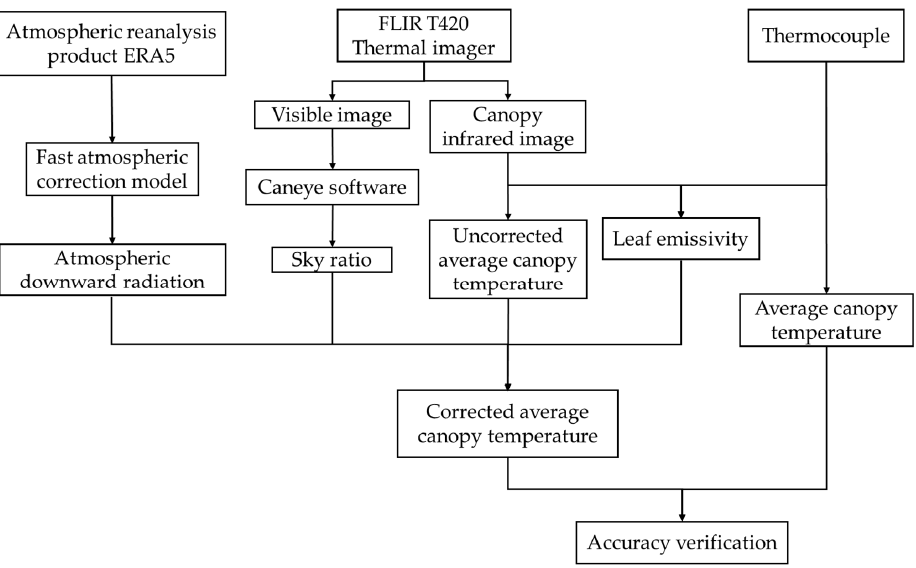
Figure 2. Main flow of the method.